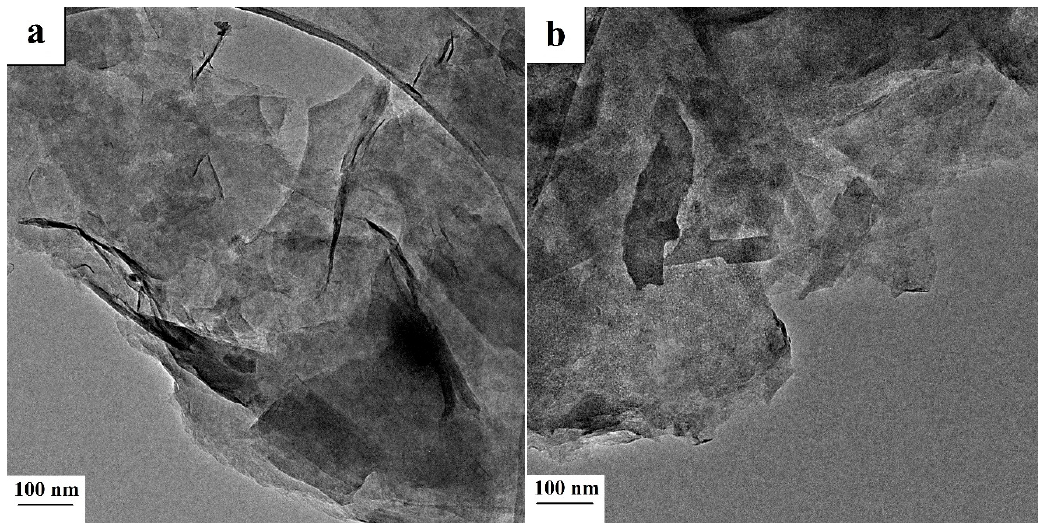
Figure 3. TEM images of crystalline features of saponite—( a ) raw and ( b ) acid-treated.